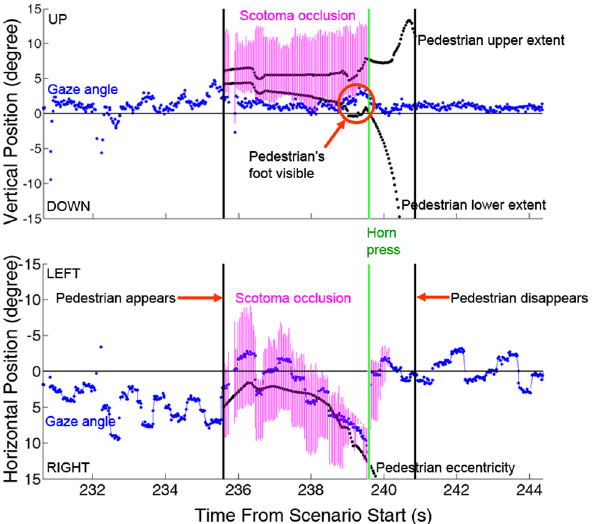
Fig 3. Example of a late pedestrian detection event in which the participant ’ s scotoma (Central Field Loss subject #4) was implicated. The upper graph depicts the pedestrian ’ s vertical position and size (black dots), the vertical extent and position of the scotoma at the horizontal position (magenta vertical lines), and the location of the vertical gaze Preferred Retinal Location (PRL) position (blue dots). Lower graph depicts horizontal position and gaze and the scotoma ’ s horizontal extent. When the pedestrian ’ s upper and lower limits are both within the vertical scotoma the pedestrian is not visible to the participant. Both the horizontal position of the pedestrian and the horizontal position and extent of the scotoma are relative to the car